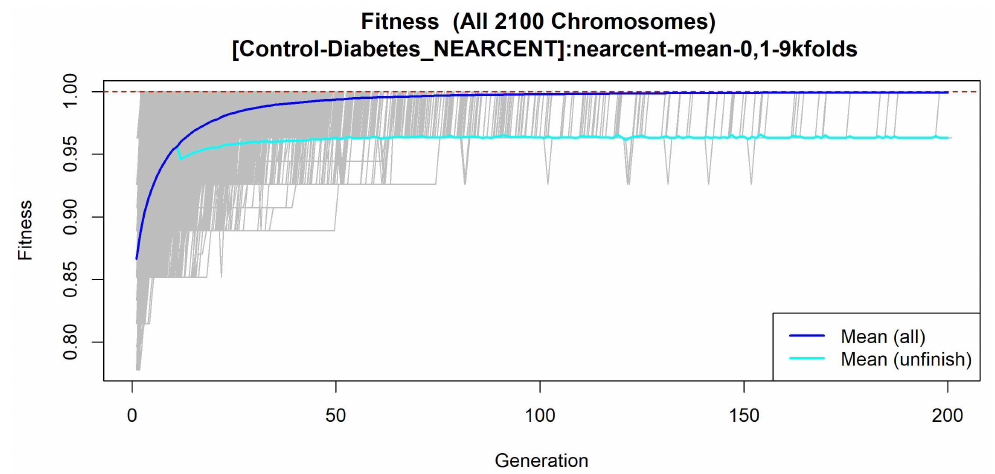
Figure 7. Evolution of maximum fitness scores over generations, using the Control-T2DM dataset. The vertical axis represents the fitness score, while the horizontal axis represents a given generation. The solid blue line represents the average fitness across all models. The average unfinished fitness is plotted as a solid cyan line and represents the average worst case expectation for all failed searches in a given generation. The red dotted line shows the established GA goal